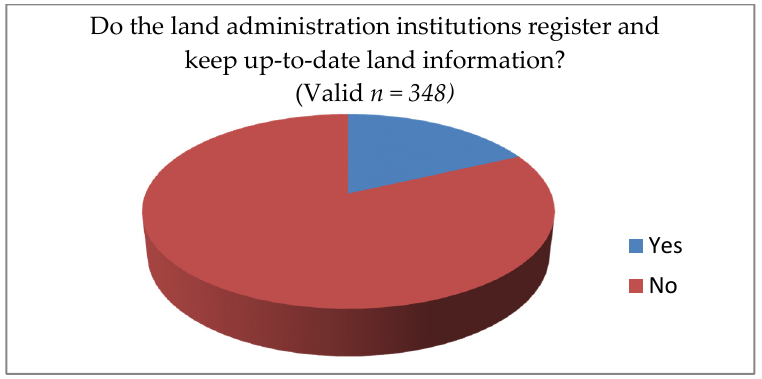
Figure 4. Responses of HH’s on the registration and updating of land information.